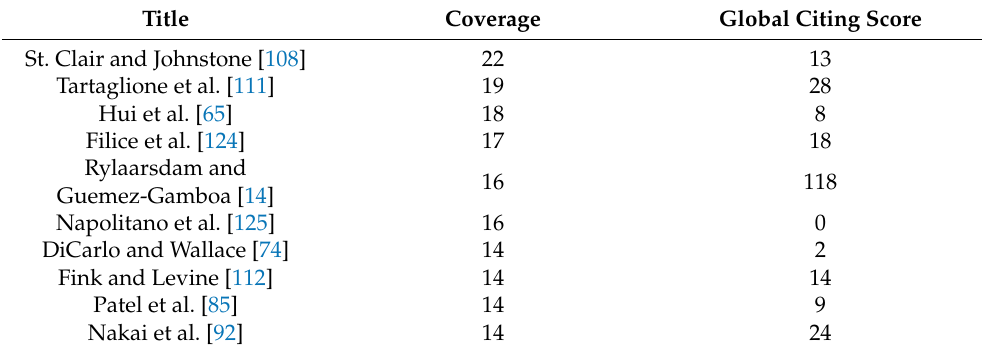
Table 7. Top 10 citing papers in Cluster #4 identified using DCA.